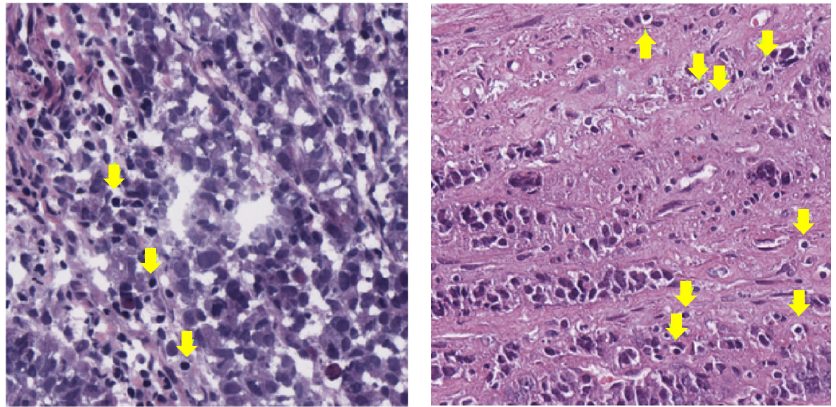
Figure 4. MSI cells in H&E-stained image patches (indicated by yellow arrows).